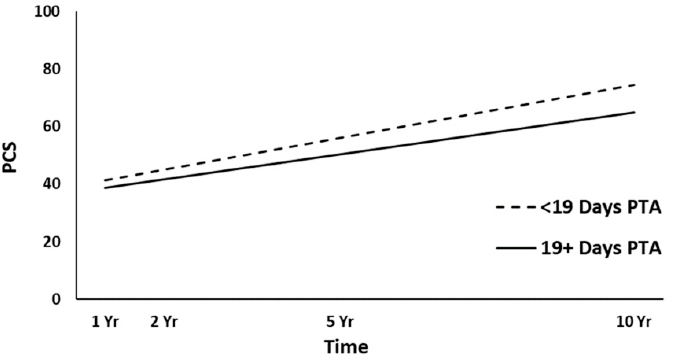
Figure 4. Main effect of post-traumatic amnesia (PTA) on the physical health (PCS) trajectories. yr, year.